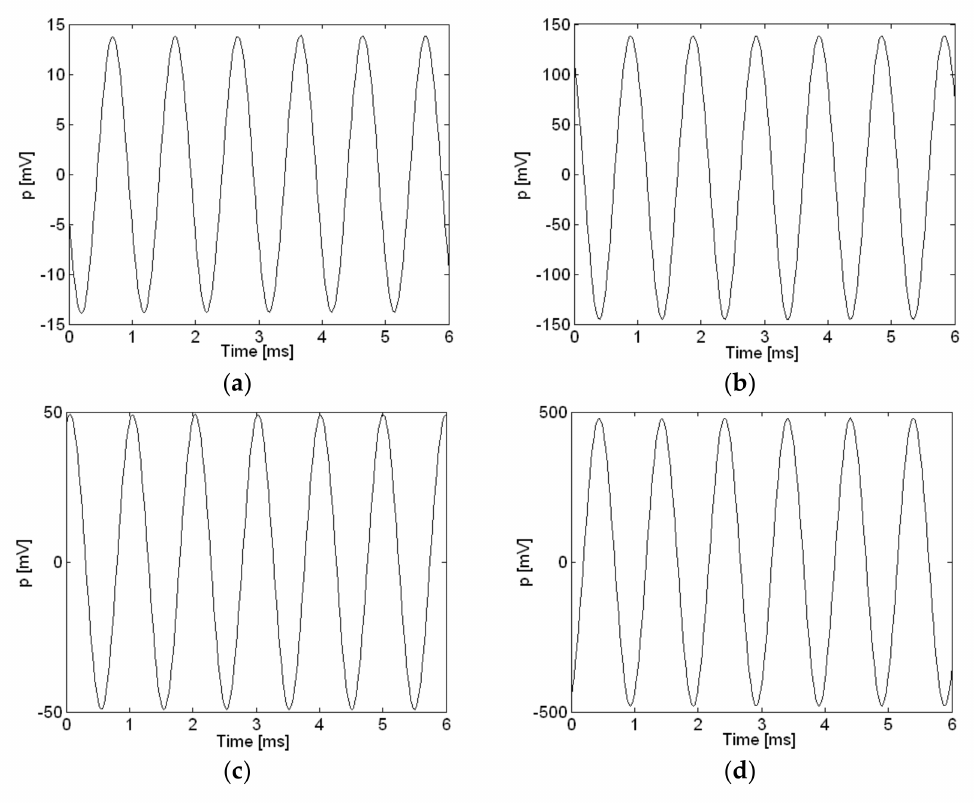
Figure 2. Calibration of microphones at 94 dB and 114 dB at 1000 Hz: ( a ) Microphone channel 1, 94 dB; ( b ) Microphone channel 1, 114 dB; ( c ) PCB microphone, 94 dB; ( d ) PCB microphone, 114